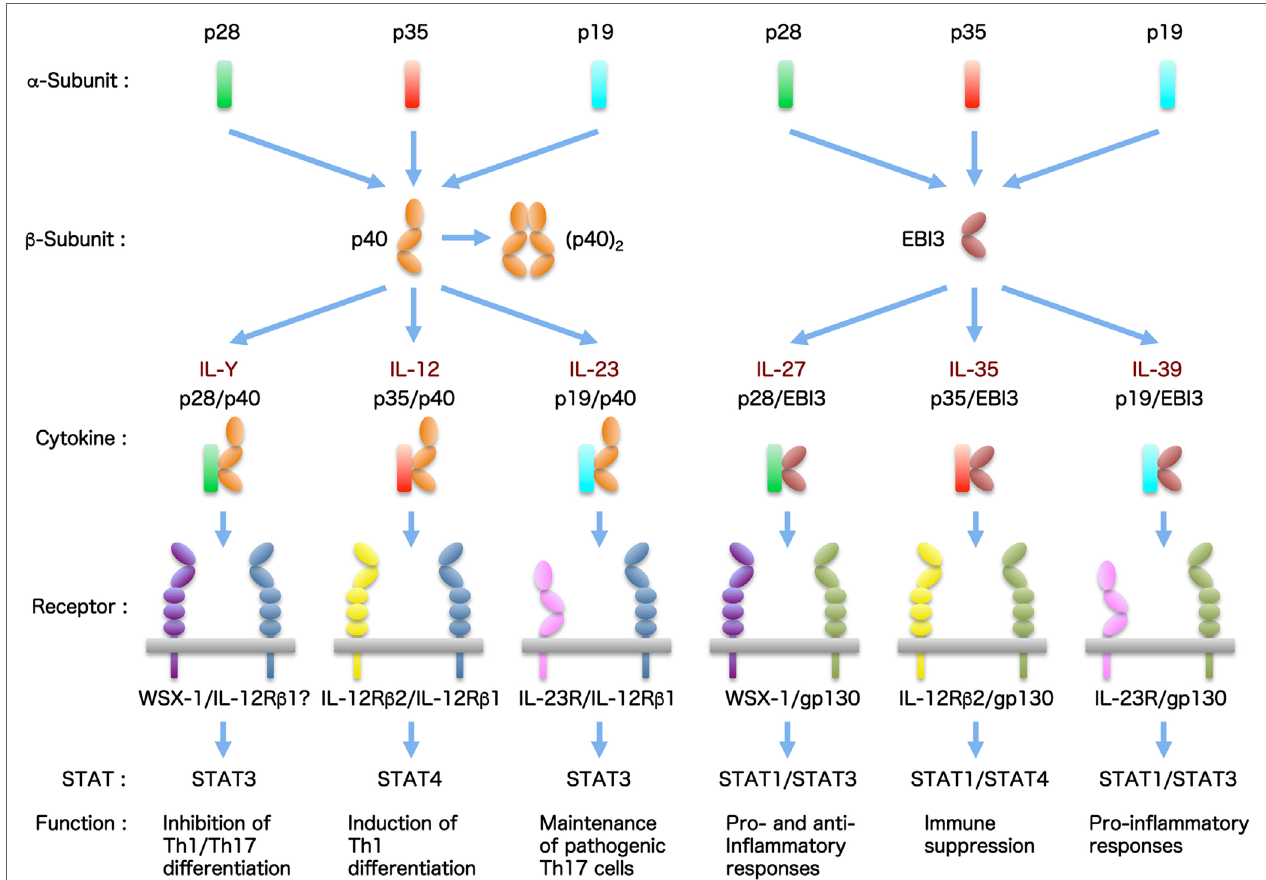
FiguRe 1 | The iL-6/iL-12 family cytokines . The IL-6/IL-12 family cytokines have pleiotropic functions and play critical roles in multiple immune responses. This cytokine family has very unique characteristics, because they are composed of two distinct subunits forming a heterodimer and each cytokine and receptor subunit shares with each other. The members of this cytokine family are increasing. Currently, there are more than six cytokines, including tentatively named cytokines.